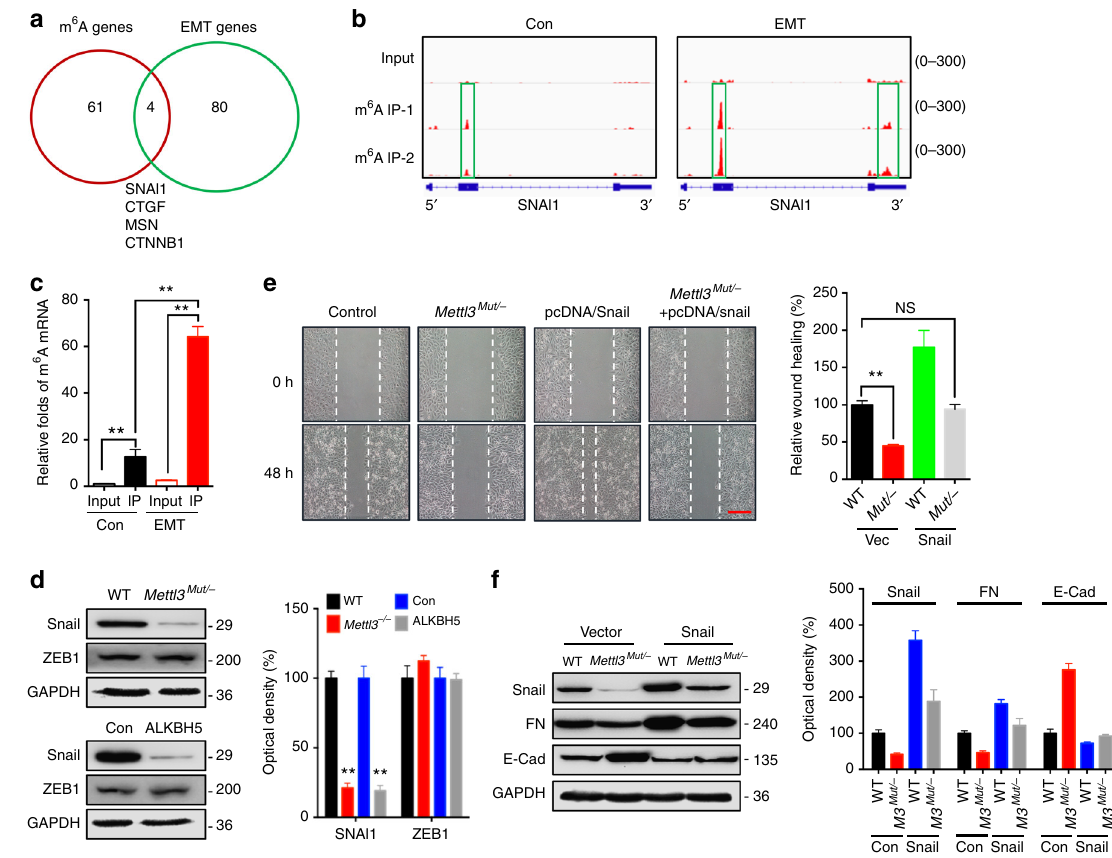
Fig. 3 Snail is involved in m 6 A-regulated EMT in cancer cells. a Overlapping of 2.0-fold m 6 A expression changes in EMT cells and EMT-related functional genes. b m 6 A peaks were enriched in CDS and 3 ′ UTRs of SNAI1 genes from m 6 A RIP-seq data. Squares marked increases of m 6 A peaks in cancer cells undergoing EMT; c m 6 A RIP-qPCR analysis of SNAI1 mRNA in the control and EMT undergoing HeLa cells. d Protein expression of Snail in Mettl3 Mut/ − or AKLBH5 transfected (24 h) HeLa cells and the control. e The wound healing of wild-type or Mettl3 Mut/ − HeLa cells transfected with or without pcDNA/ Snail for 48 h were recorded (left) and quantitatively analyzed (right). f Wild-type or Mettl3 Mut/ − HeLa cells were transfected with or without pcDNA/Snail for 48 h, expression of Snail, FN and E-Cad were measured by western blot analysis. Data are presented as means ± SD from three independent experiments. * p < 0.05, NS, no signi fi cant, by Student ’ s t test. Red bar = 200 μ